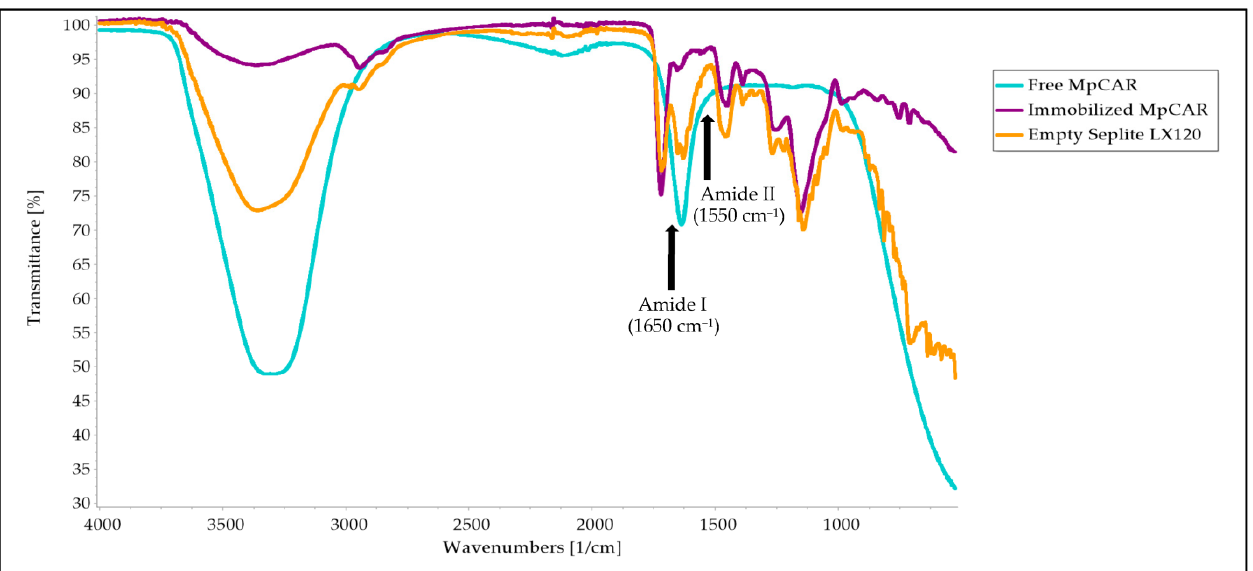
Figure 8. Overlaid Fourier-Transform Infrared Spectroscopy (FTIR) profiles of free carboxylic acid reductase from Mycobacterium phlei ( Mp CAR), immobilized Mp CAR onto Seplite LX120, and empty Seplite LX120. Blue line: Free Mp CAR; Purple line: Immobilized Mp CAR; Orange line: Empty Seplite LX120.